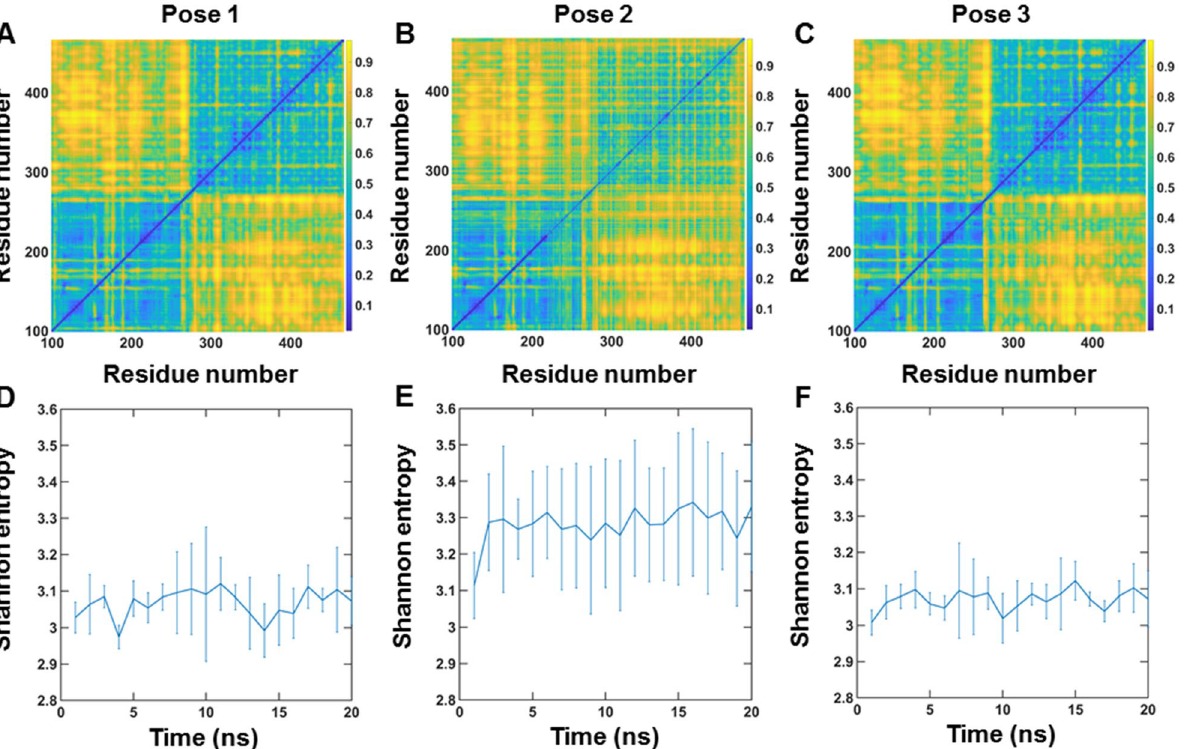
Figure 4. Pose-dependent correlation between residues in active MMP1 and quantification of allostery using Shannon entropy at 37 °C. ( A , B , C) Mean correlations between residues in three repeats of simulations for poses 1, 2, and 3, respectively, at 37 °C. Correlations are normalized between 0 (blue) and 1 (yellow). Yellowish colors indicate higher correlations. ( D , E , F ) Shannon entropy calculated from correlation plots for poses 1 (S = 3.07 ± 0.04, mean ± SEM), 2 (S = 3.28 ± 0.05, mean ± SEM), and 3 (S = 3.07 ± 0.03, mean ± SEM), respectively. For details, see supplementary information and Fig. S4. The error bars in ( D – F ) represent the standard deviations of three repeats of simulations for poses 1, 2, and